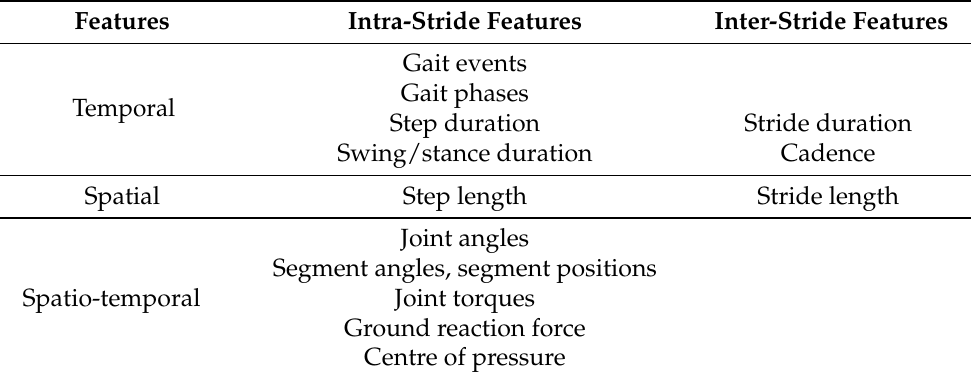
Figure 2. Collecting unique articles from the databases was carried out sequentially, starting with Scopus where 697 articles were extracted and of which 695 unique records were identified. Out of the 335 unique records identified from Web of Science, 290 articles already appeared in the results from Scopus and hence the remaining 45 unique records were added. Similarly, 34 from Cochrane and 17 from PubMed were added to the list of unique records. Table 3. Classification of the most commonly used gait features into intra-stride and inter-stride as well as into temporal, spatial, and spatio-temporal features. The scope of this review is primarily limited to the intra-stride temporal gait features (ISTGFs) highlighted in